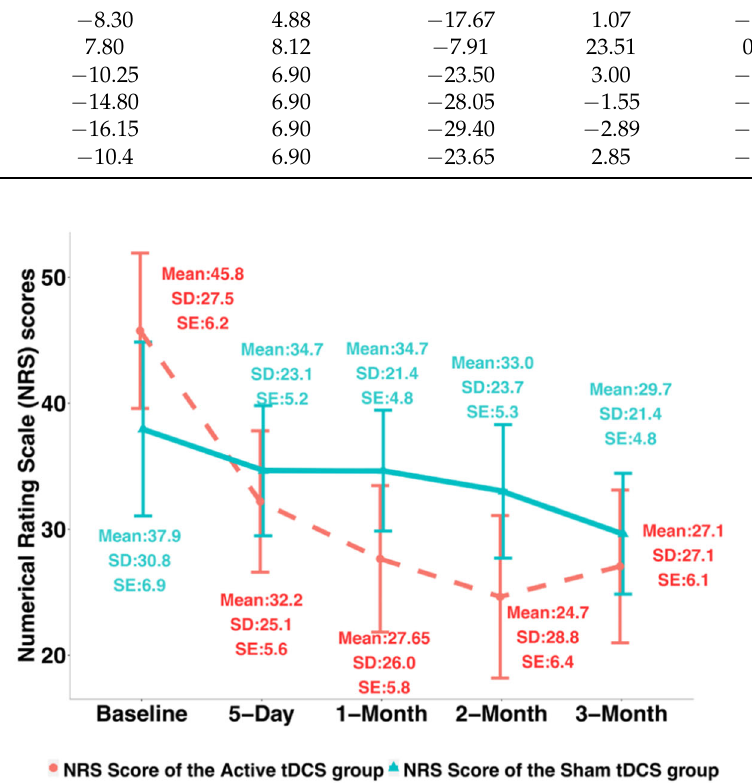
Figure 2. Numerical Rating Scale (NRS) scores over time of the active and the sham tDCS groups ( n = 40). The dashed red line represents the mean NRS scores of the active tDCS group, and the solid green line represents the mean NRS score of the sham tDCS group.